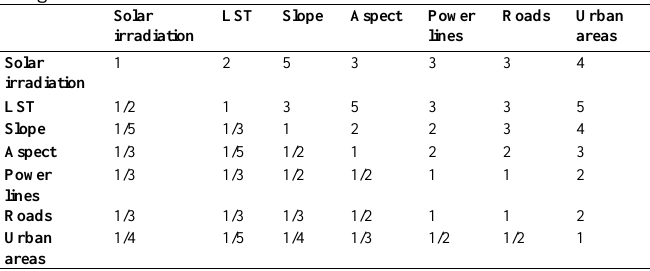
Table 6. Pair-wise comparison matrix of criteria and estimated weights.